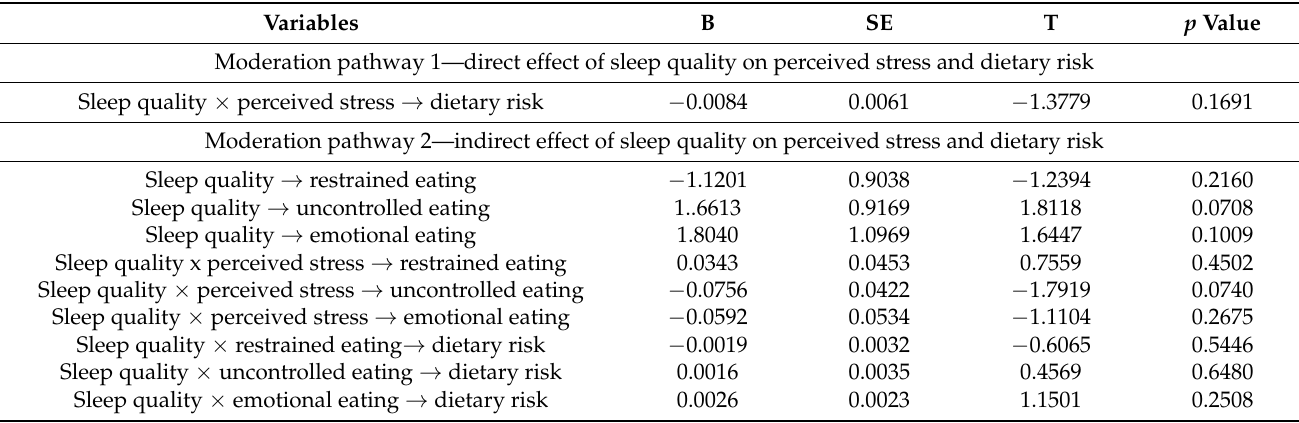
Table 8. Model 3 moderation analysis (sleep quality as a